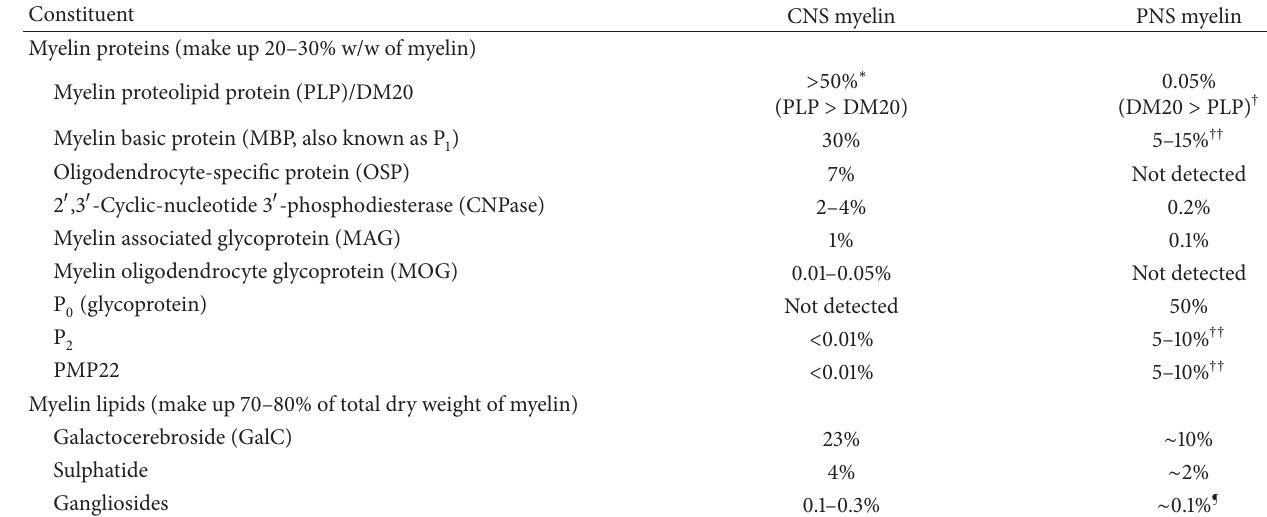
Table 1: Some of the constituents of myelin and their relative distribution (assembled from information in [2, 48, 170–175]). Constituent CNS myelin PNS myelin Myelin proteins (make up 20–30% w/w of myelin) Myelin proteolipid protein (PLP)/DM20